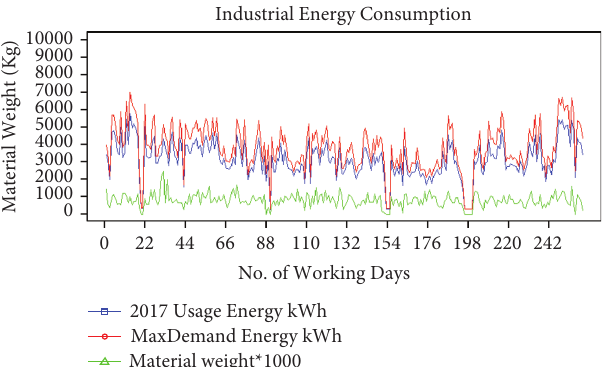
Figure 10: Total materials weight of manufactured products with the demand of energy and usages of energy for the number of working days in